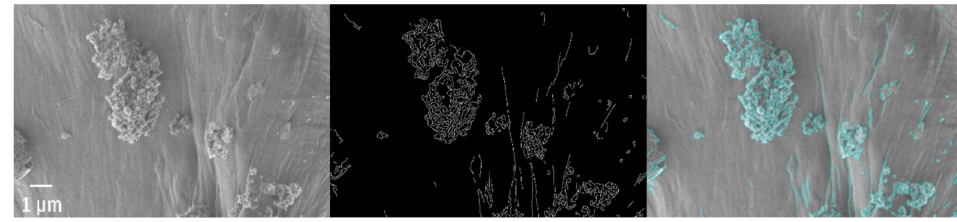
Figure 9. The rubbish bag with adsorbed material and the length of the total edge ~217.5 µ m.